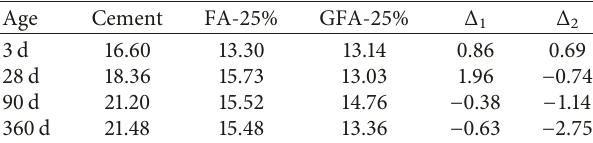
Figure 5: TG-DTG curves of composite cementitious materials. Table 2: The content of Ca(OH) 2 in the hardened cement paste at different ages